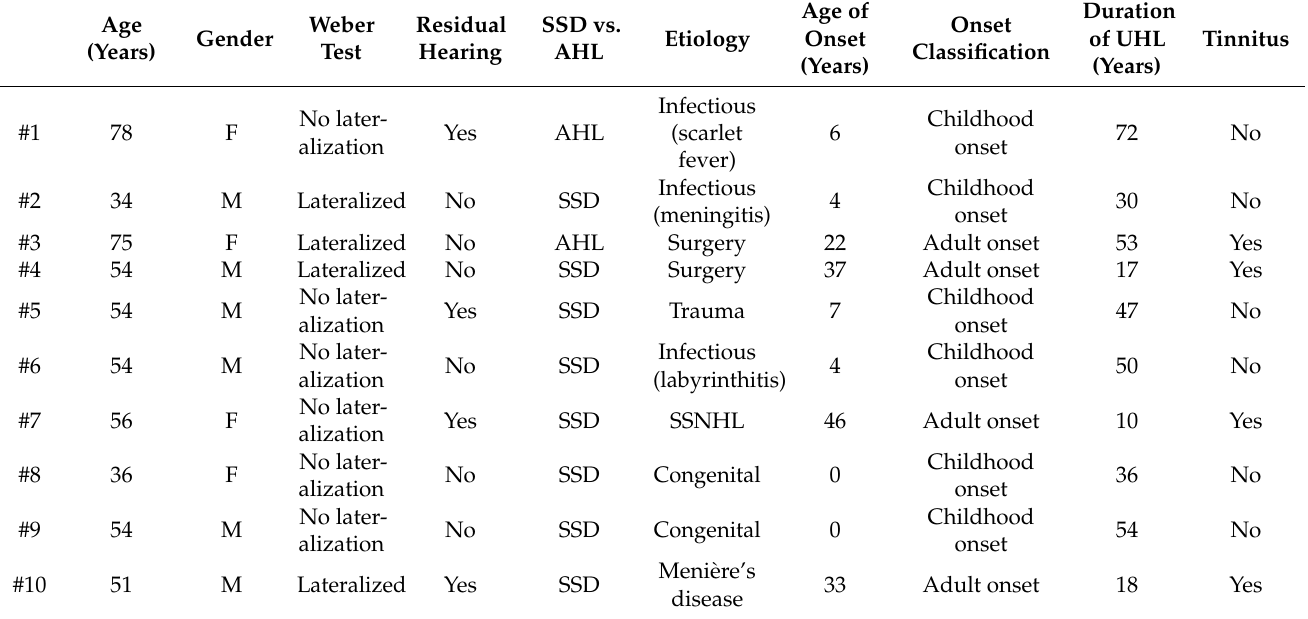
Table 1. Patient characteristics of the study cohort. AHL: asymmetric hearing loss; SSD: single-sided deafness; UHL: unilateral profound hearing loss. SSNHL: sudden sensorineural hearing loss. F: female; M: